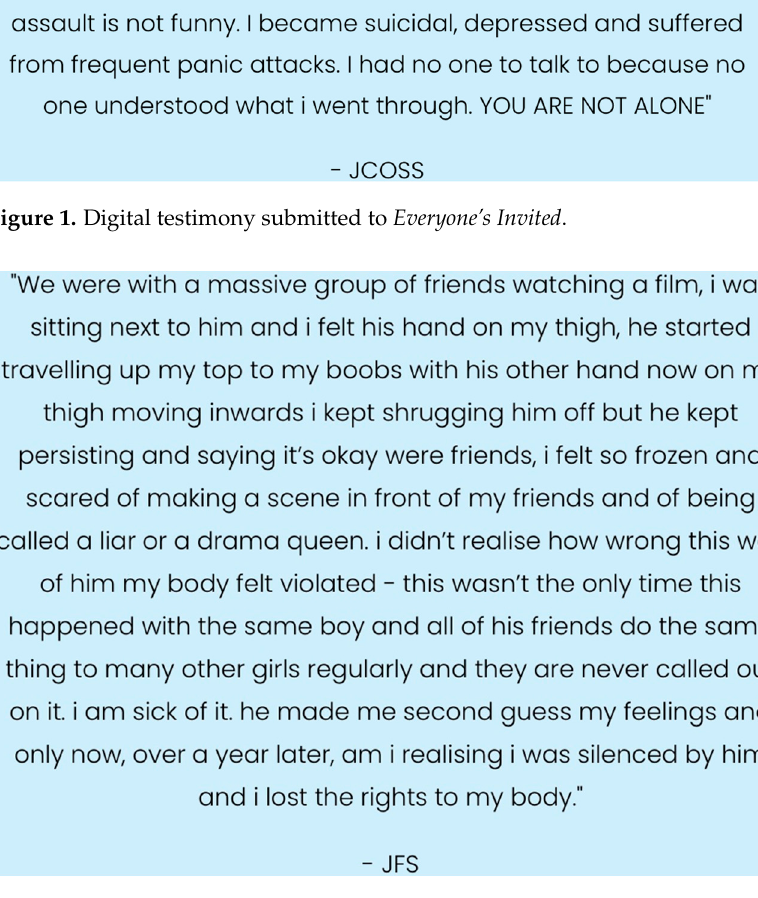
Figure 2. Digital testimony submitted to Everyone’s Invited.